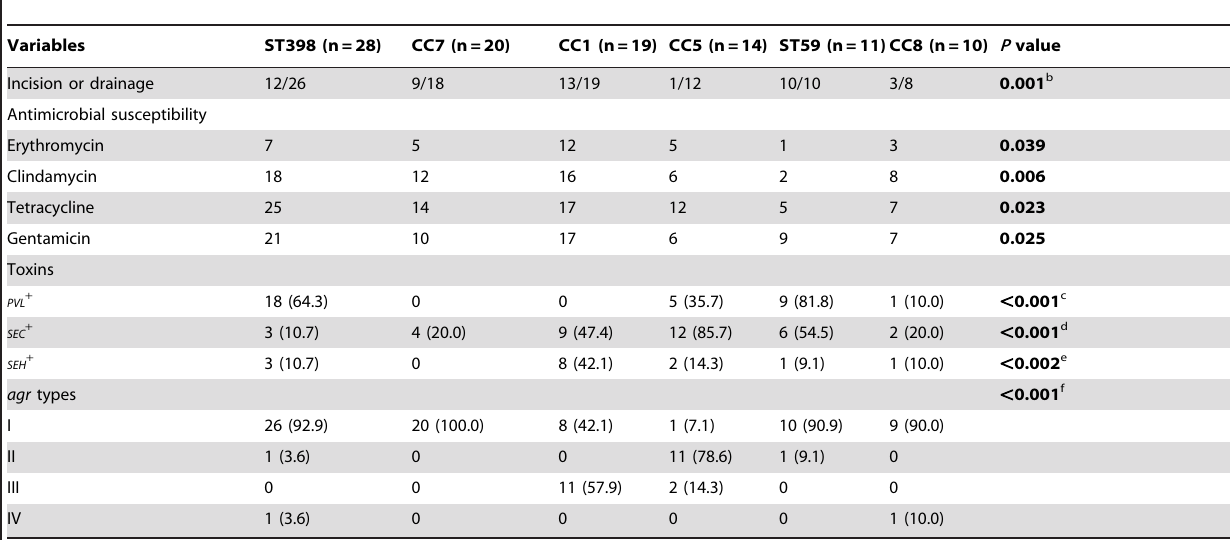
Table 4 . Comparison of clinical information, toxins, agr types and susceptibility among the major S. aureus clones (%) a .